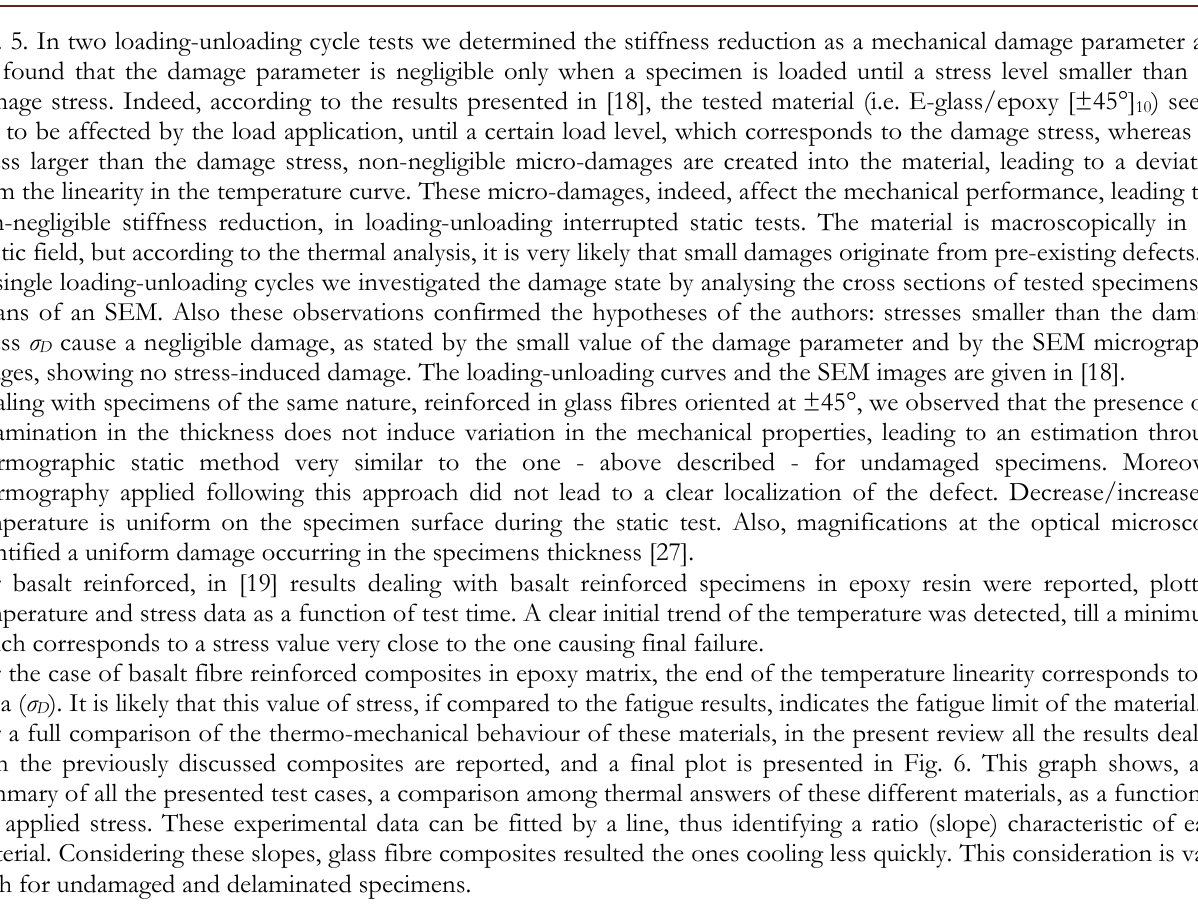
-GE for glass/epoxy,  -GE,del for glassy/epoxy with D D